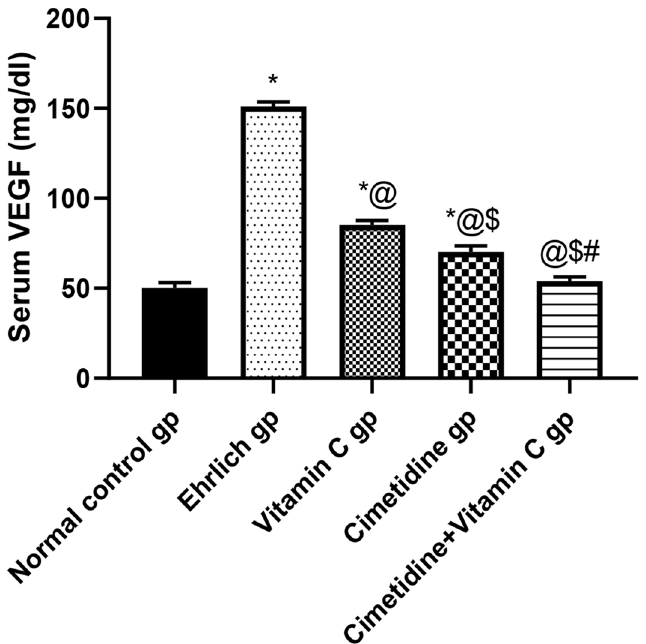
Figure 5. The changes in the serum VEGF concentration following treatment with cimetidine at a dose of 200 mg/kg/day, vitamin C at a dose of 4 g/kg/day, and their combination for 15 days after Ehrlich induction of breast cancer in mice. Data are presented as mean ± SD. * is significantly different from the normal control group, P < 0.05. @ is significantly different from Ehrlich untreated group, P < 0.05. $ is significantly different from the vitamin C- treated group, P < 0.05. # is significantly different from the cimetidine-treated group, P <